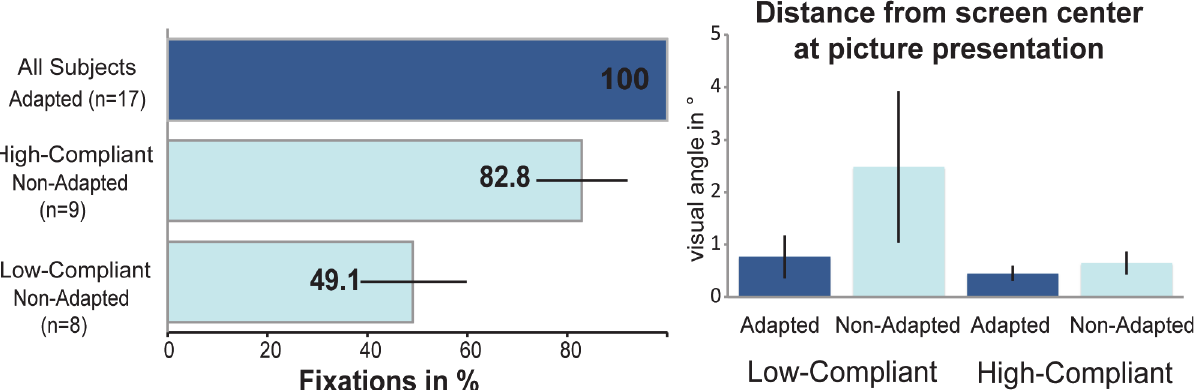
Fig 4. Behavioral results. The post-hoc analysis of eye tracking data shows the correct functionality of the software by 100% fixations for all subjects in the adapted condition. In addition, it shows difference in fixation compliance and gaze distance from the center of the screen for the non-adapted picture presentation. Due to the bimodal distribution of this parameter, subjects were divided into